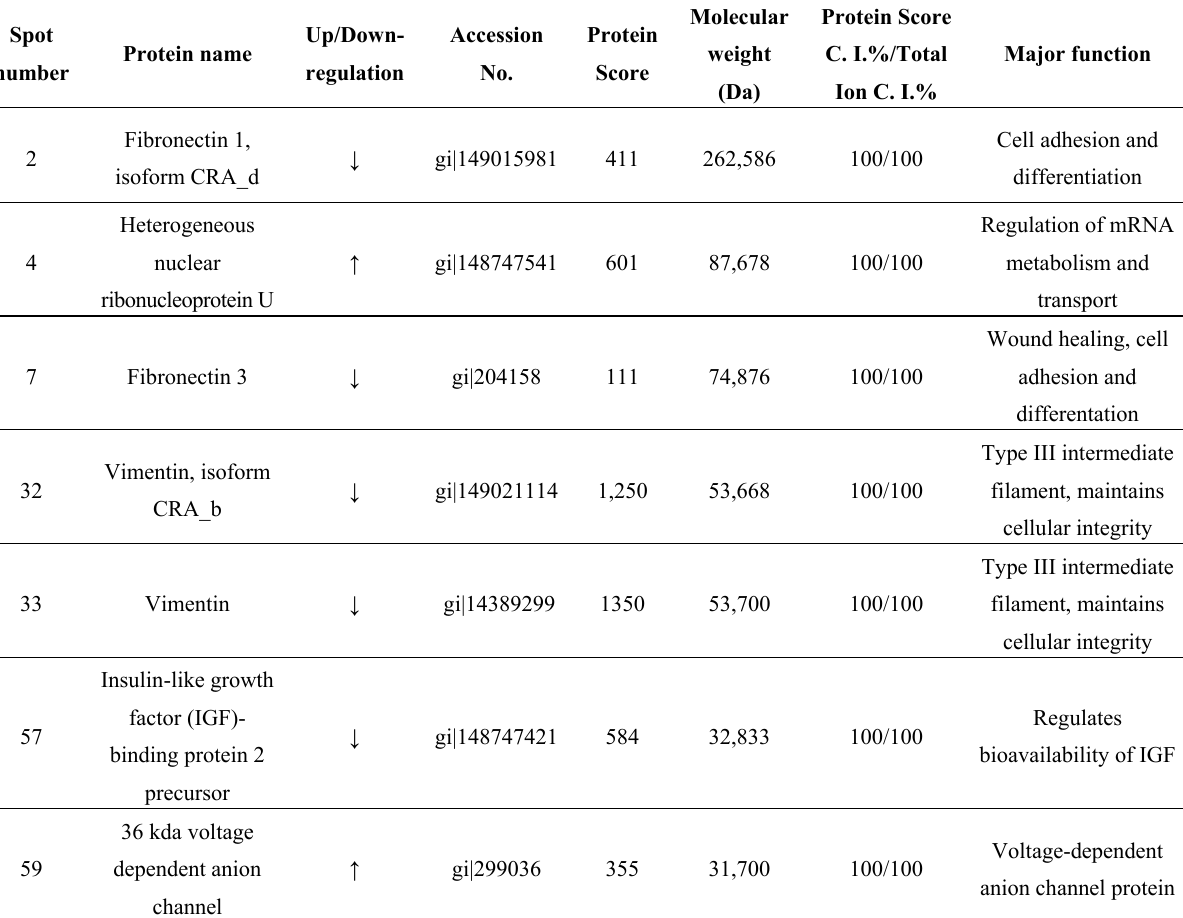
Table 2. List of VSMC proteins up or downregulated by H Nox1-dependent